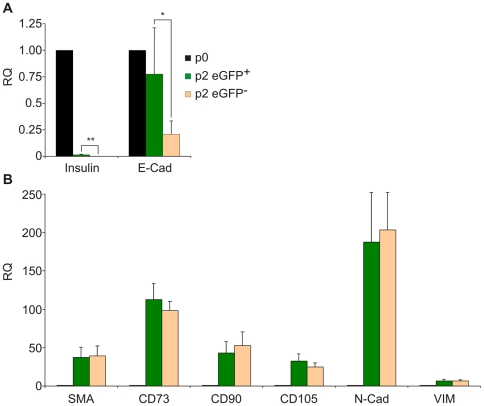
Changes in expression of epithelial and mesenchymal genes in sorted eGFP+ and eGFP− cells following 2 weeks in culture.RNA was extracted from cells at the indicated passage number and analyzed by qRT-PCR. A, analysis of epithelial genes. B, analysis of mesenchymal genes. Data represent relative quantification (RQ) (compared to passage 0) and are mean±SE (n = 3 donors). *p<0.05; ** p<0.005.